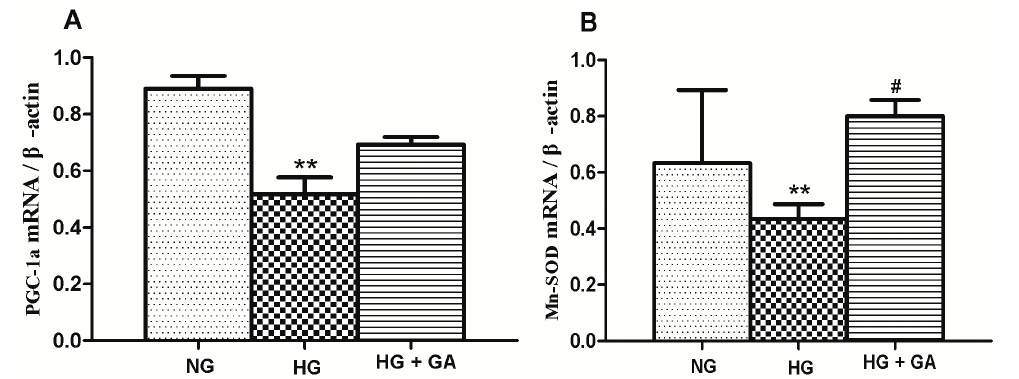
The effects of GA on Mn-SOD and PGC-l α mRNA in NRK-52E cells have been examined. Exposure of NRK-52E decreased the expression of Mn-SOD and PGC-l α mRNA level in the HG group compared with NG group. The expression of Mn-SOD increased in GA group ( p < 0.05), but PGC-l α mRNA level did not increase in GA group (Figure 8A,B) ( p > 0.05). Figure 8. Real-time RT-qPCR analyses. Effect of GA on Mn-SOD ( A ) and PGC-1 α (PPAR γ co-activator 1 α ) ( B ) mRNA expression was measured by real-time fluorescent quantitative RT-qPCR. Values were normalized to mouse housekeeping gene β -actin and then normalized to sham samples. The mRNA levels of Mn-SOD and PGC-1 α in the HG group were significantly lower than those in the NG group ( ** p < 0.01). The mRNA levels of Mn-SOD began to return to higher levels in the GA group ( # p < 0.01). But no change was observed in PGC-l α mRNA level for GA group compared with HG